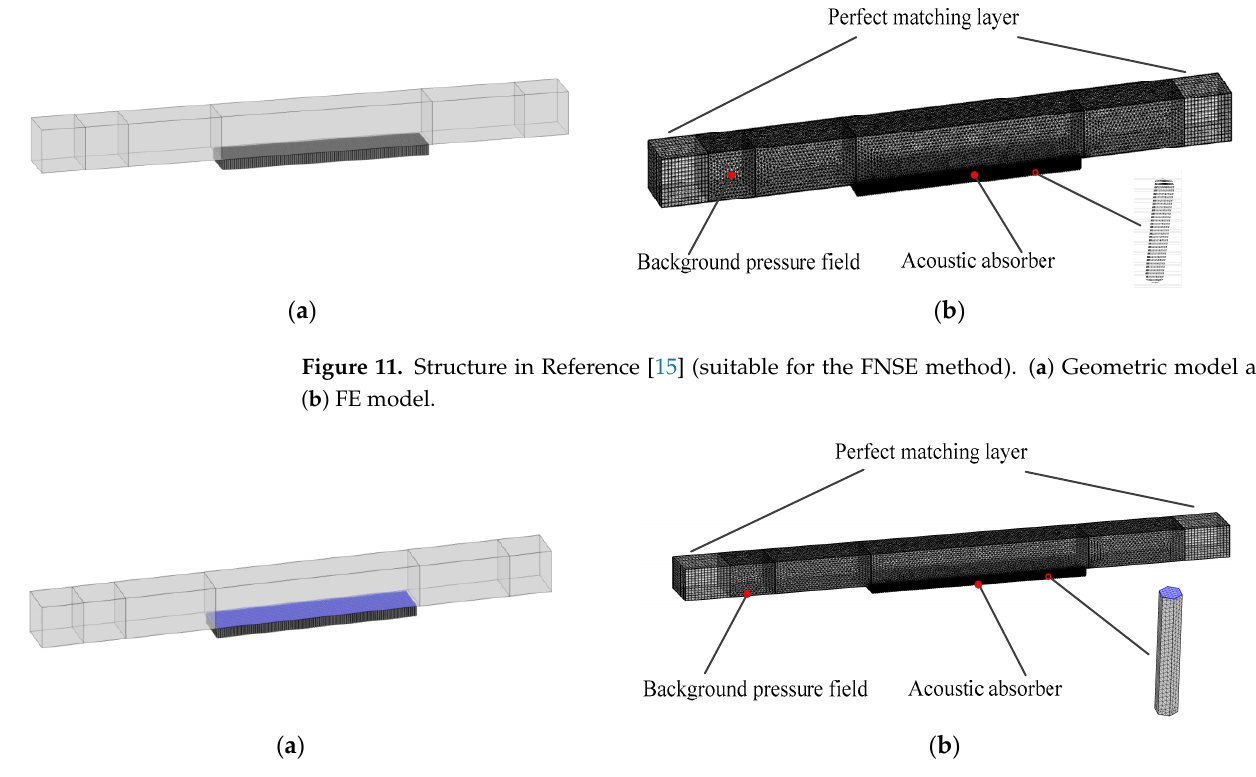
Figure 10. Schematic view of the structure in Reference [15].